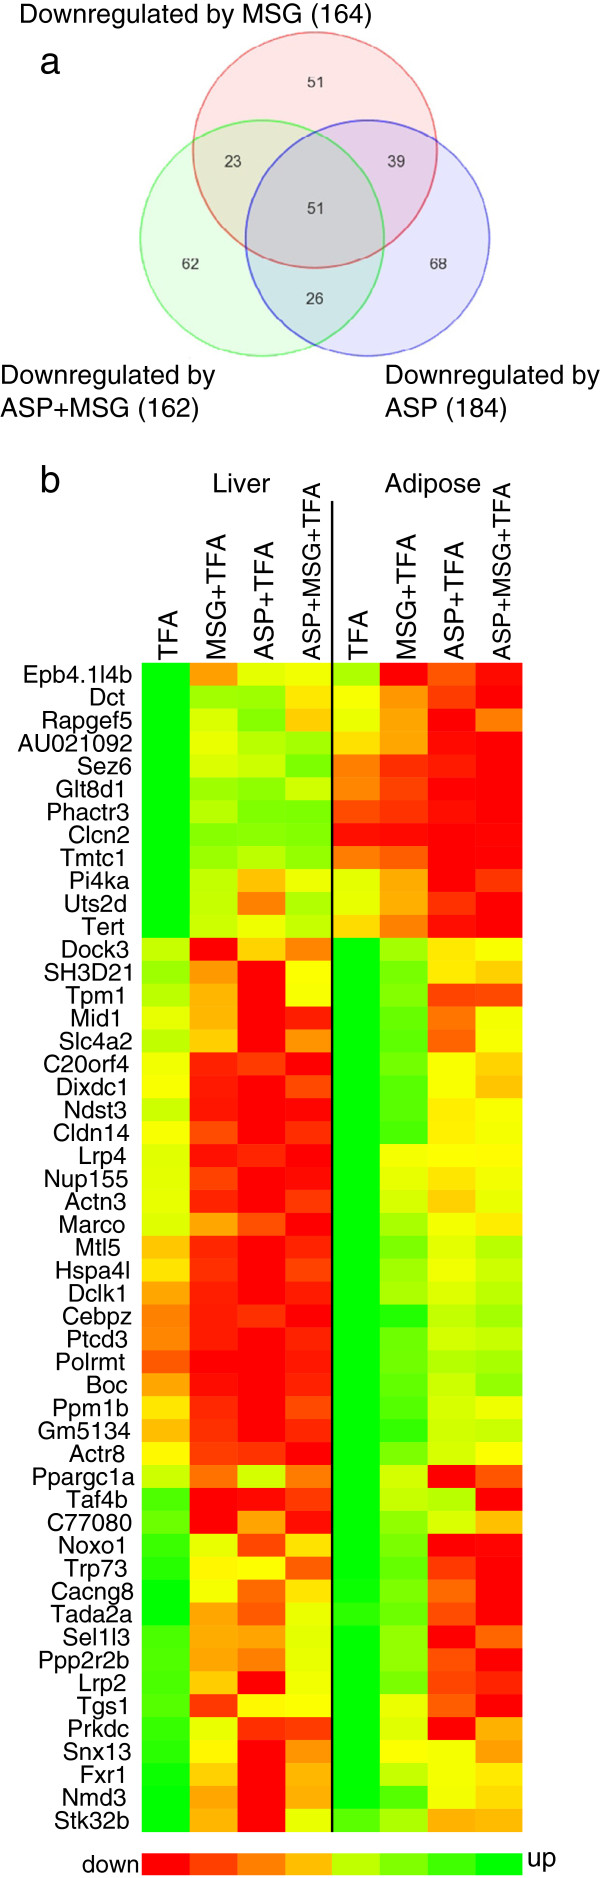
Downregulated gene expression shared by liver and adipose tissue. (a) Venn diagram displaying numbers of downregulated DEGs common to both liver and adipose tissue induced by either ASP, MSG or the combination of both additives. (b) 2-dimentional heat map of 51 downregulated DEGs common to both hepatic and adipose tissue (P < 0.05, stringency ≥ ± 1.4-fold change in expression).